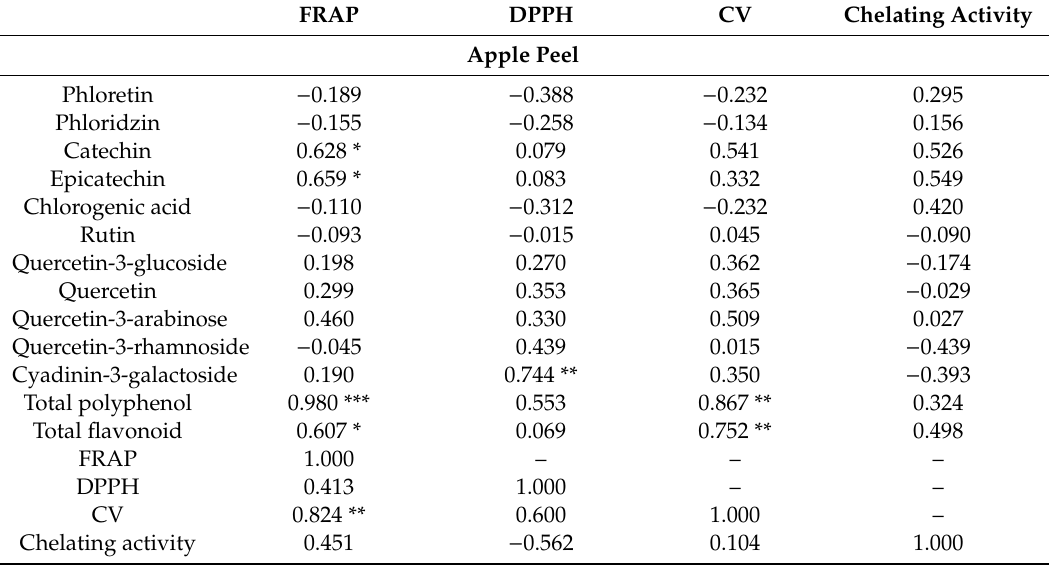
Table 5. Correlation coe ffi cient between phenolic compounds and antioxidant capacity tests and linear correlation coe ffi cient between di ff erent methods for antioxidant capacity assessment in apple peel and